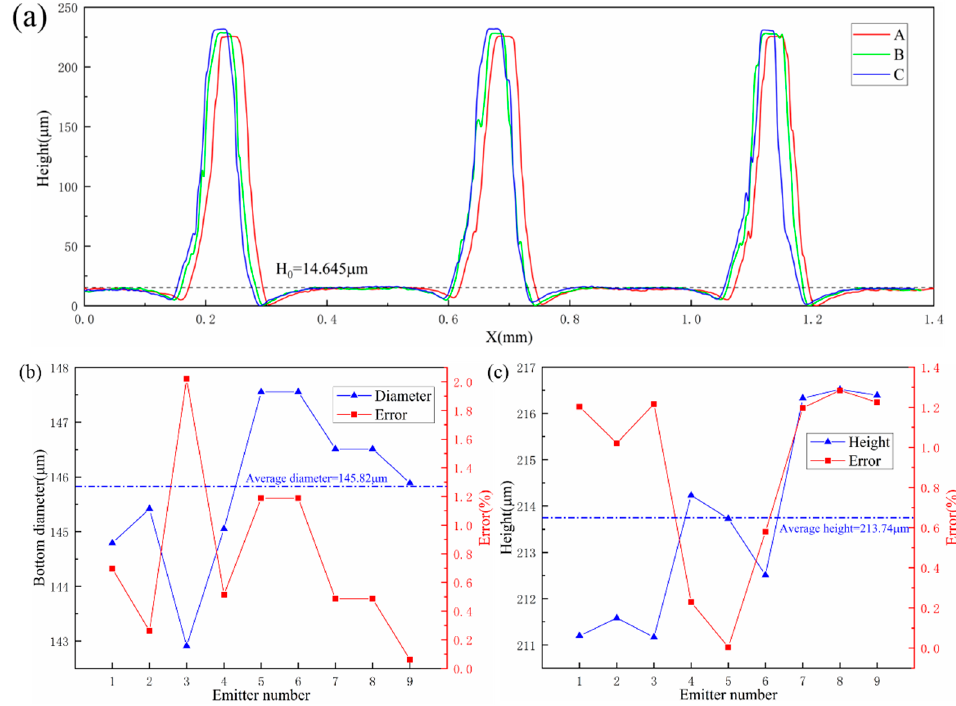
Figure 6. ( a ) Profile drawing, ( b ) bottom diameter, and ( c ) height of the test samples.